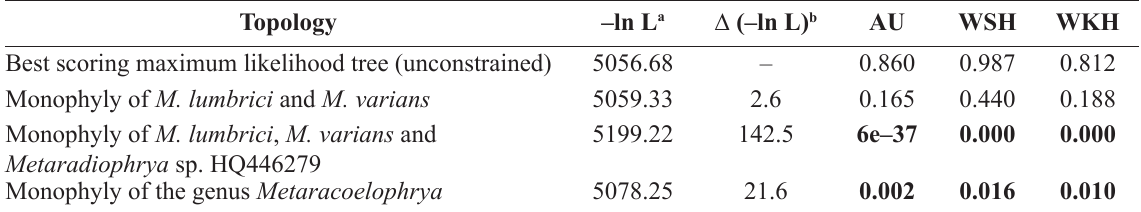
a Log likelihood of a phylogenetic tree. b Difference between log likelihoods of constrained and best scoring (unconstrained)